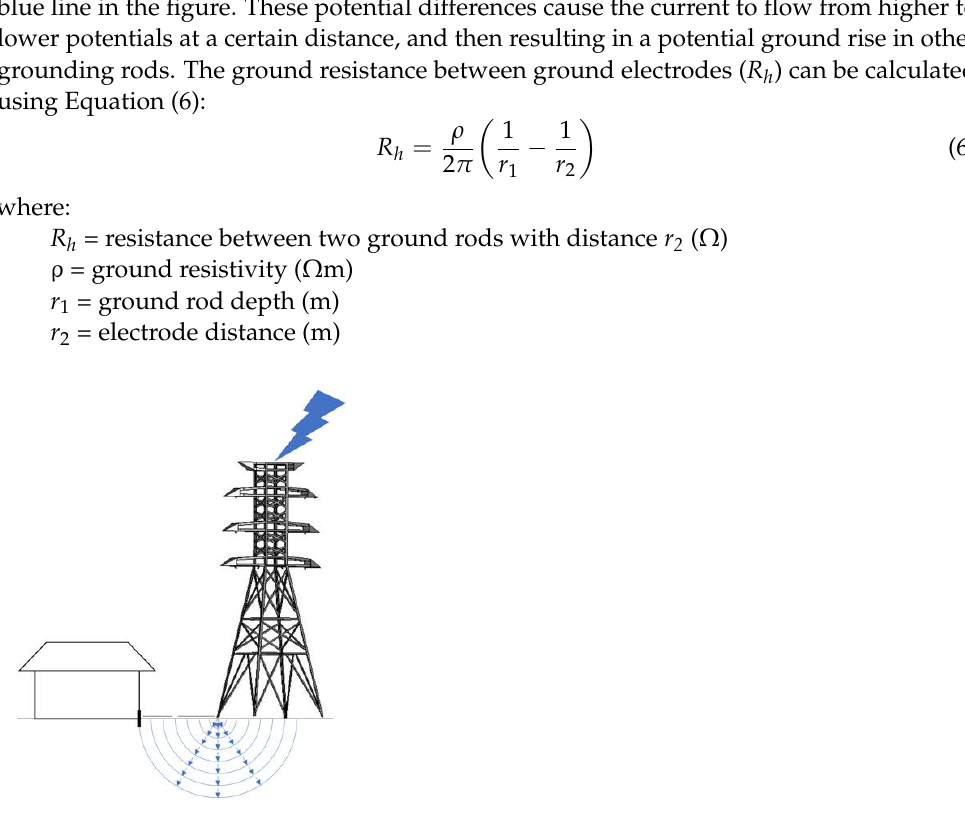
Figure 2. GPR phenomenon.